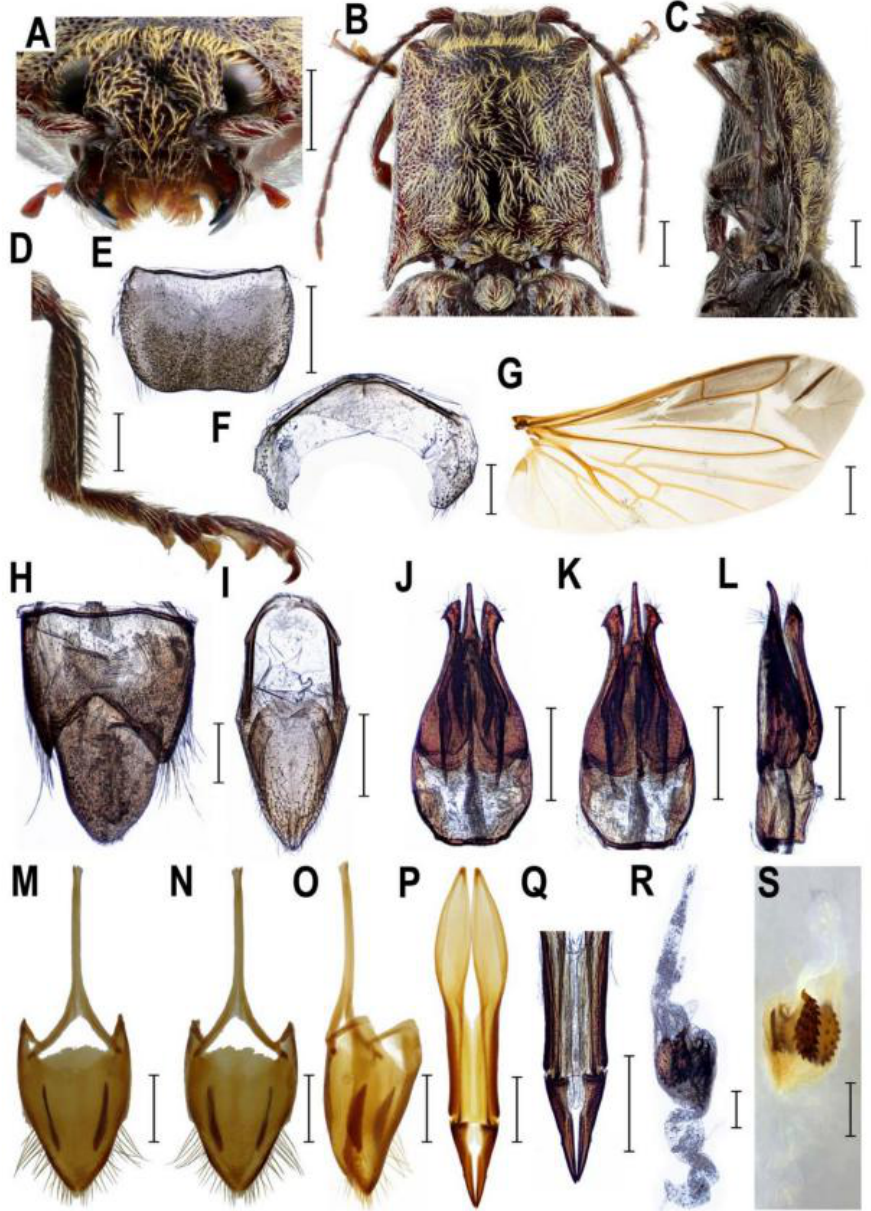
Figure 3. Morphology of Senodonia spp. Senodonia cf. quadricollis , Indonesia, female ( A – D , G , M – S ), Senodonia jeanvoinei , Vietnam, male ( E , F , H – L ). ( A ) head, frontal view; ( B ) pronotum, dorsal view; ( C ) prosternum, lateral view; ( D ) right metatibia and metatarsus; ( E ) male abdominal tergite VIII; ( F ) male abdominal sternite VIII; ( G ) hind wing; ( H ) male abdominal tergites IX–X; ( I ) male abdominal sternite IX; ( J ) aedeagus, dorsal view; ( K ) aedeagus, ventral view; ( L ) aedeagus, lateral view; ( M ) female abdominal sternite VIII, dorsal view; ( N ) female abdominal sternite VIII, ventral view; ( O ) female abdominal sternite VIII, lateral view; ( P ) ovipositor; ( Q ) apical part of ovipositor; ( R , S ) bursa copulatrix. Scale bars = ( G ): 2 mm; ( A – C , E , I – S ): 1 mm; ( D , F , H ): 0.5